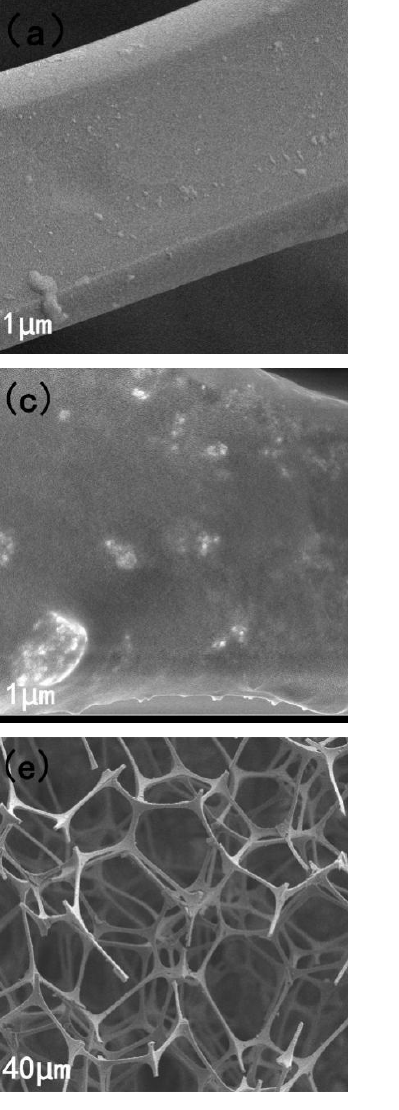
Figure 3. ( a – c ) are the scanning electron micrographs of MS, Fe 3 O 4 /MS and PDMS@Fe 3 O 4 /MS 1 μ